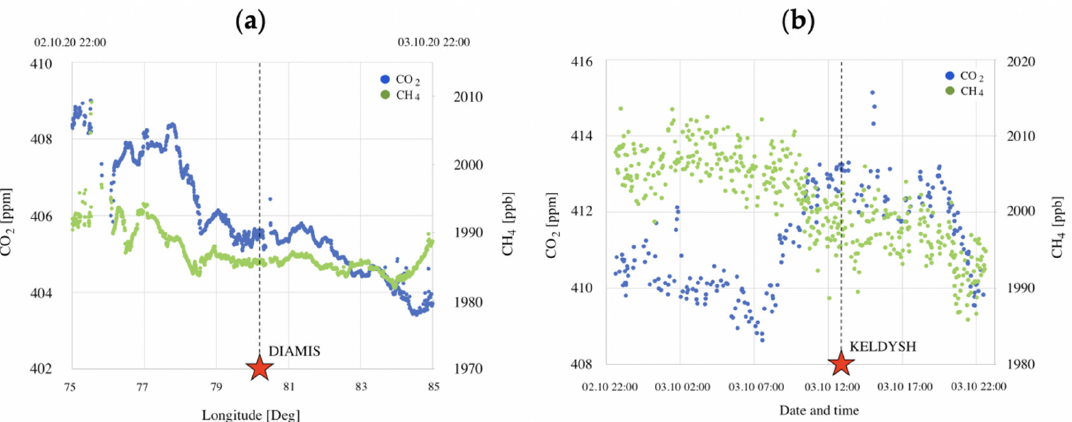
Figure 6. Simultaneous patterns of carbon dioxide and methane mole fractions observed at 02–03.10.2020 over the domain of the Kara Sea (75–85° E) in the “DIAMIS” footprint at the research vessel “Academician Mstislav Keldysh” (AMK-85) ( a ) and in the coastal atmosphere at the measurement station “DIAMIS” ( b ). The vertical dashed line indicates the position of the station regarding the measurements on the research vessel ( left figure) and time when the research vessel passed the longitude of the station ( right figure). QC minute averages are shown.